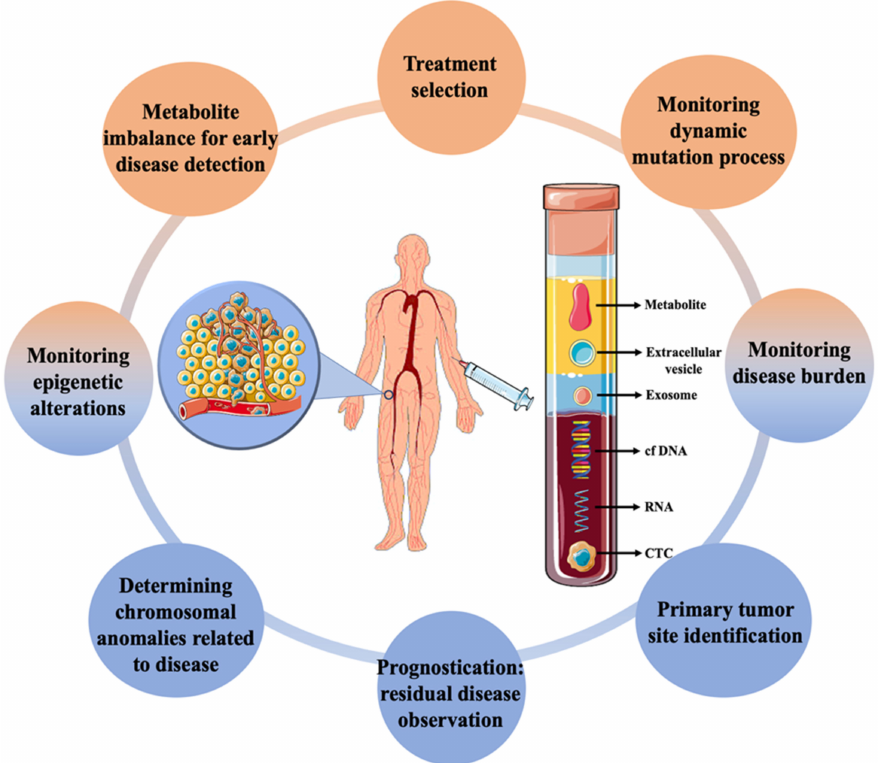
Figure 1. Applications of liquid biopsy in cancer diagnosis along with the different biomarkers commonly targeted using the